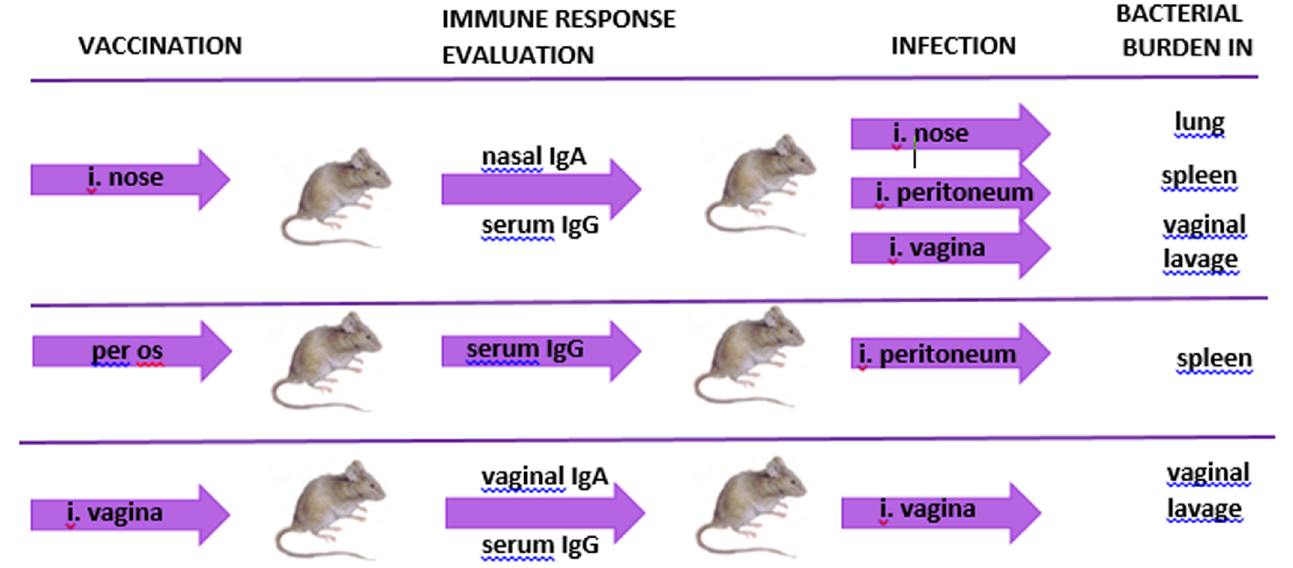
Fig 3. Immunological study and analysis of E . faecium L3 Bac +protective properties. General setup.